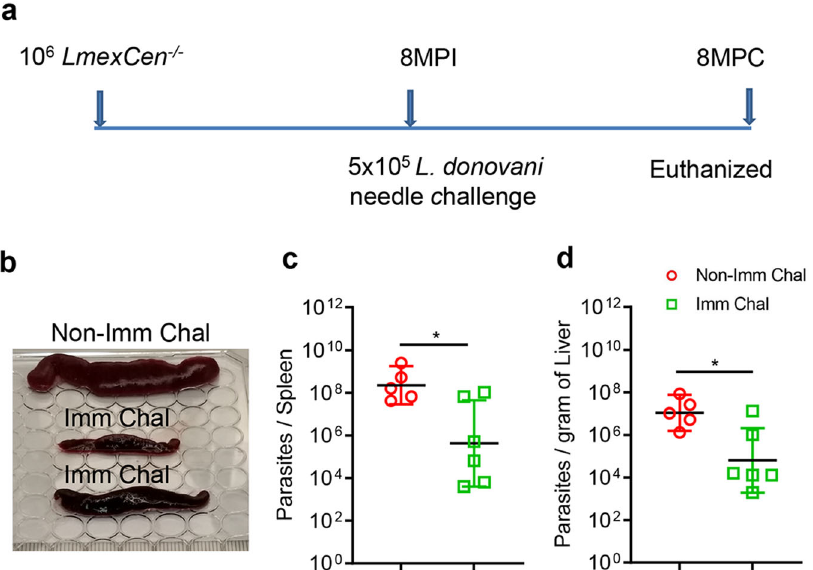
Fig. 5 LmexCen − / − immunization confers long term protection against needle challenge L. donovani infection in hamsters. a Schematic representation of experimental plan to determine the long-term protective ef fi cacy of LmexCen − / − parasites against L. donovani infection through needle injection. b Representative spleen picture from each group. Spleen ( c ) and Liver ( d ) parasite burden of LmexCen − / − immunized (Imm Chal, n = 6) and age matched non-immunized (Non-Imm Chal, n = 5) hamsters were determined at 8 months post needle challenge. Results (the geometric means with 95% Cl) are from one experiment (* p = 0.03 values were determined by Mann – Whitney two-tailed test). MPI Months post-immunization, MPC months